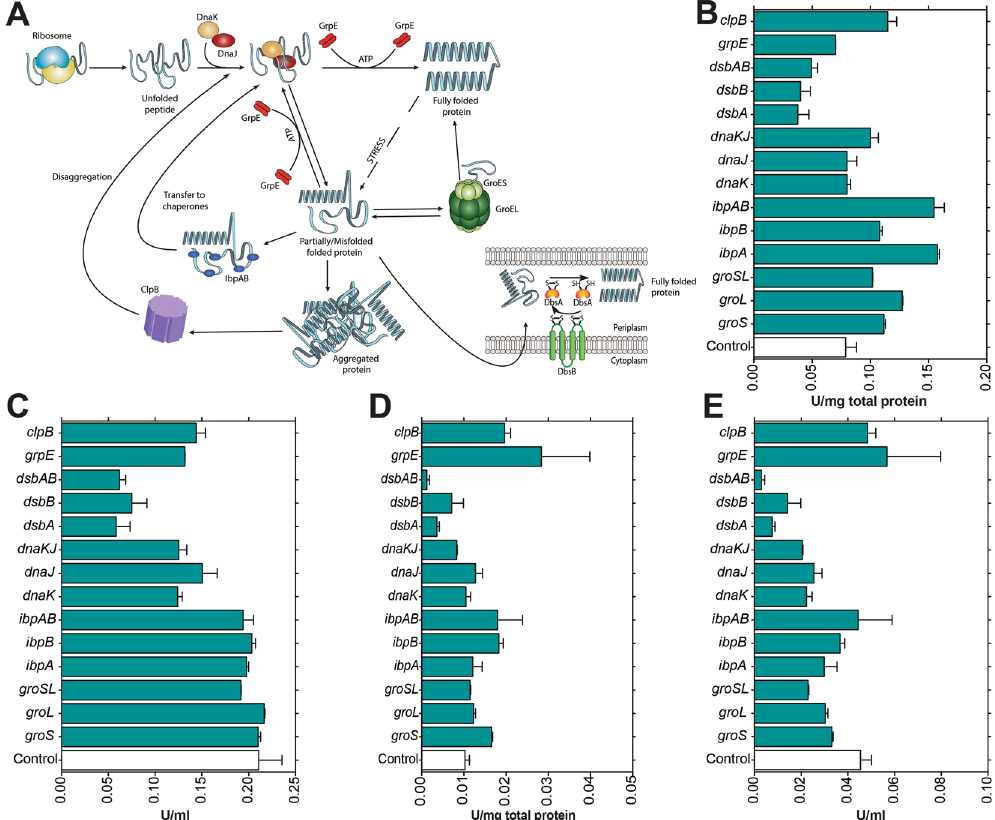
Figure 4. Production of rhGALNS in E. coli BL21(DE3) when different chaperones were co-expressed. ( A ) The biological role of the overexpressed chaperones in protein folding in E. coli . The scheme shows the importance of the different chaperones in proper folding of nascent peptides, recovery from partially/misfolded proteins and the response to stress. ( B ) Specific activity in the extracellular fraction. ( C ) Volumetric activity in the extracellular fraction. ( D ) Specific activity in the intracellular fraction. ( E ) Volumetric activity in the intracellular fraction. Enzyme activity was assessed 24 hours after induction using optimal (0.5 mM) IPTG concentration. A Student’s t-test was performed to assess significance, where ( ** ) corresponds to a p-value < 0.01. Specific activities are expressed as U rhGALNS/(mg total protein) and volumetric activities as U/ml. As noticed, the overexpression of individual chaperone proteins did not aid in the increase of rhGALNS activity. The names shown in this panels B to E correspond to the overexpressed chaperones. Full names of the plasmids used can be found in Table